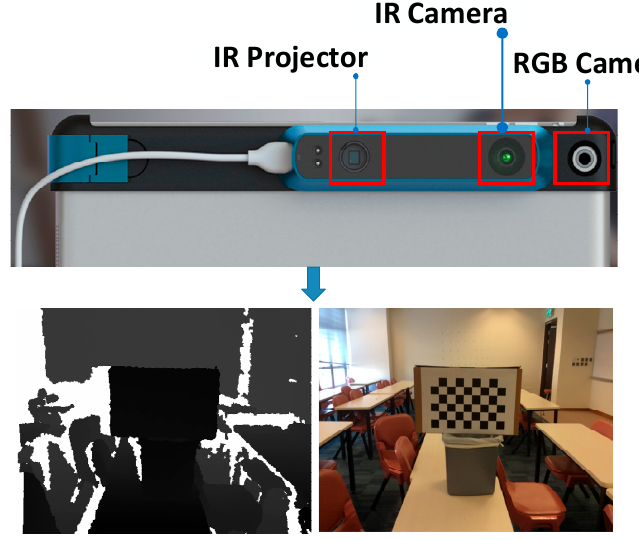
Figure 1. ( top ) The hardware scheme of the RGB-D sensor (sensor with RGB camera and Depth camera); ( bottom left ) the acquired depth image; and ( bottom right ) the acquired RGB image.